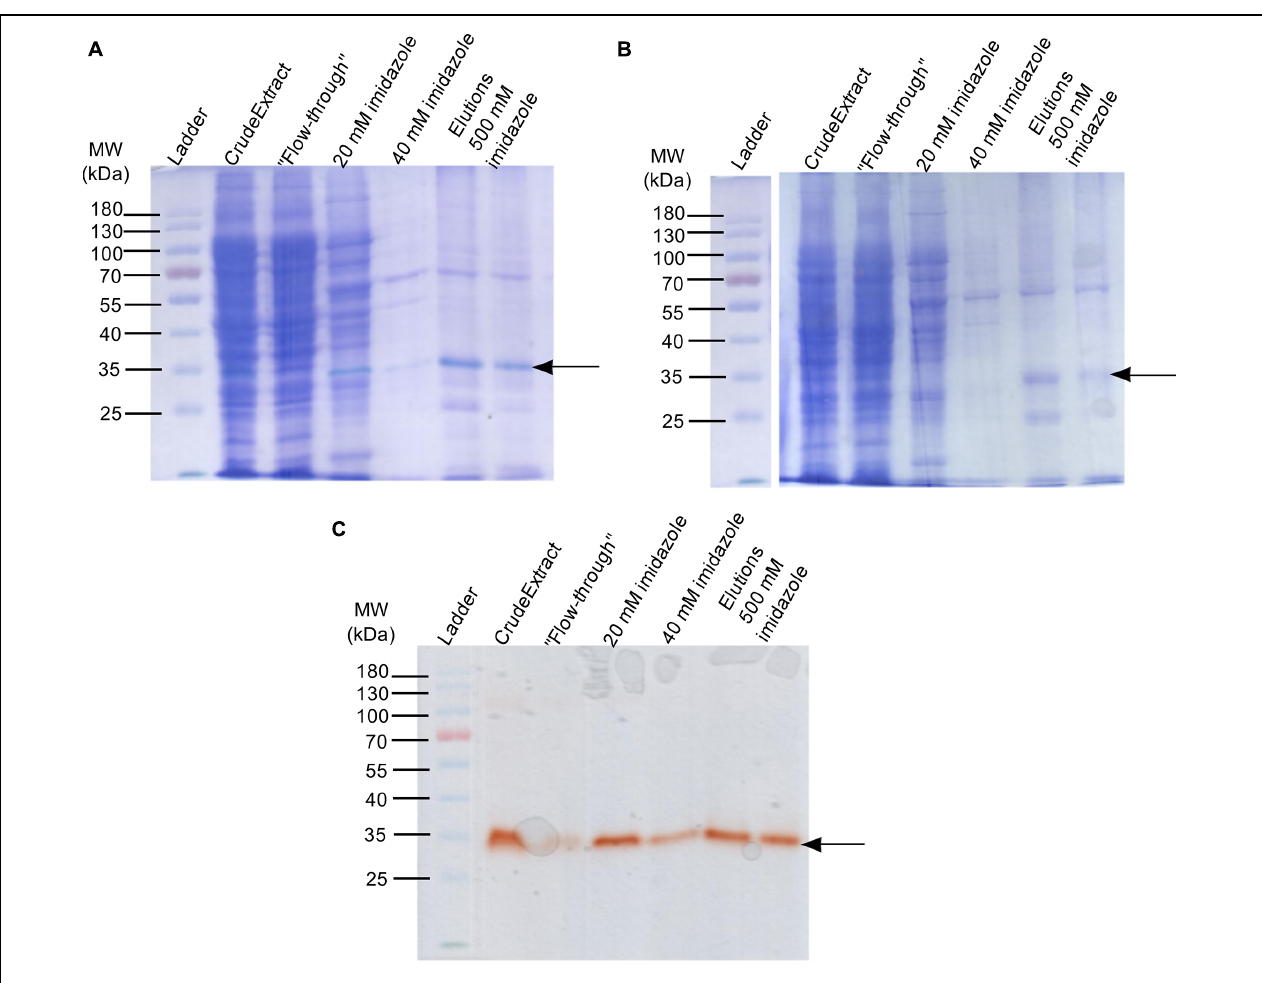
FIGURE 4 | Production and purification of the recombinant B6T173 (ZmPrx35) protein in E. coli (using the vector pET19b). (A) Sequential staining (guaiacol- H 2 O 2 + Coomassie R-250) of the POD fractions obtained by